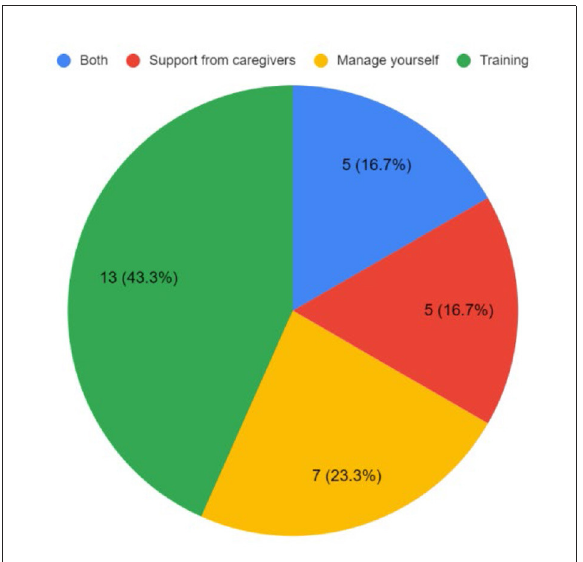
FIGURE2 Training needs of the stroke survivors and